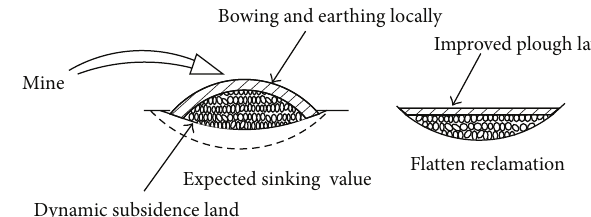
Figure 4: The dynamic prereclamation schematic diagram of gangue backfilled